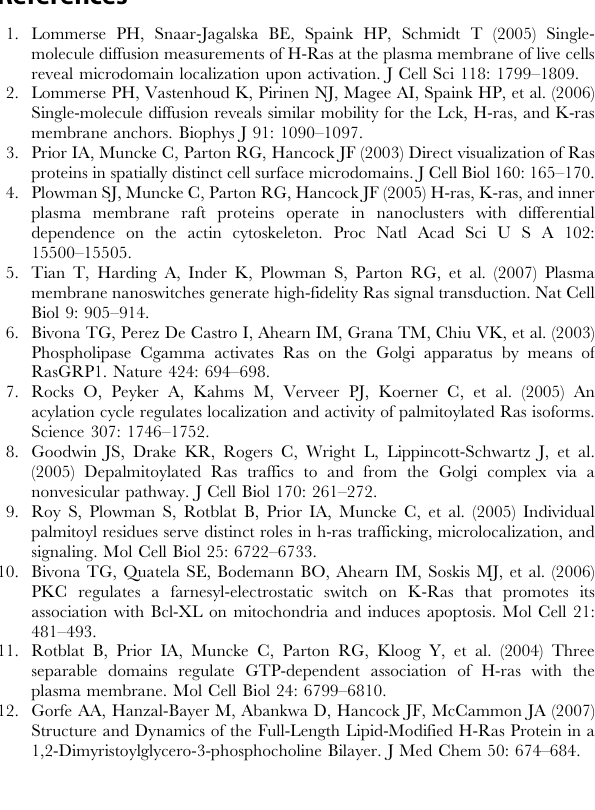
Figure S1 Electron micrographs showing plasma membrane sheets labeled with anti-mRFP gold. Representative plasma membrane sheet generated from BHK cells expressing A) GFP- H-RasG12V, Gal-1 and mRFP-Raf-1 or B) YC-H-RasG12V, YN- Gal-1 and mRFP-Raf-1 labeled with anti-mRFP primary conjugated directly to 5 nm gold. The x,y co-ordinates of the gold pattern were used to calculate Ripley’s k-function (see figure 3A). Bars represent 200 nm and 500 nm respectively. Figure S2 HEK293 cells were co-transfected with YN-Gal1